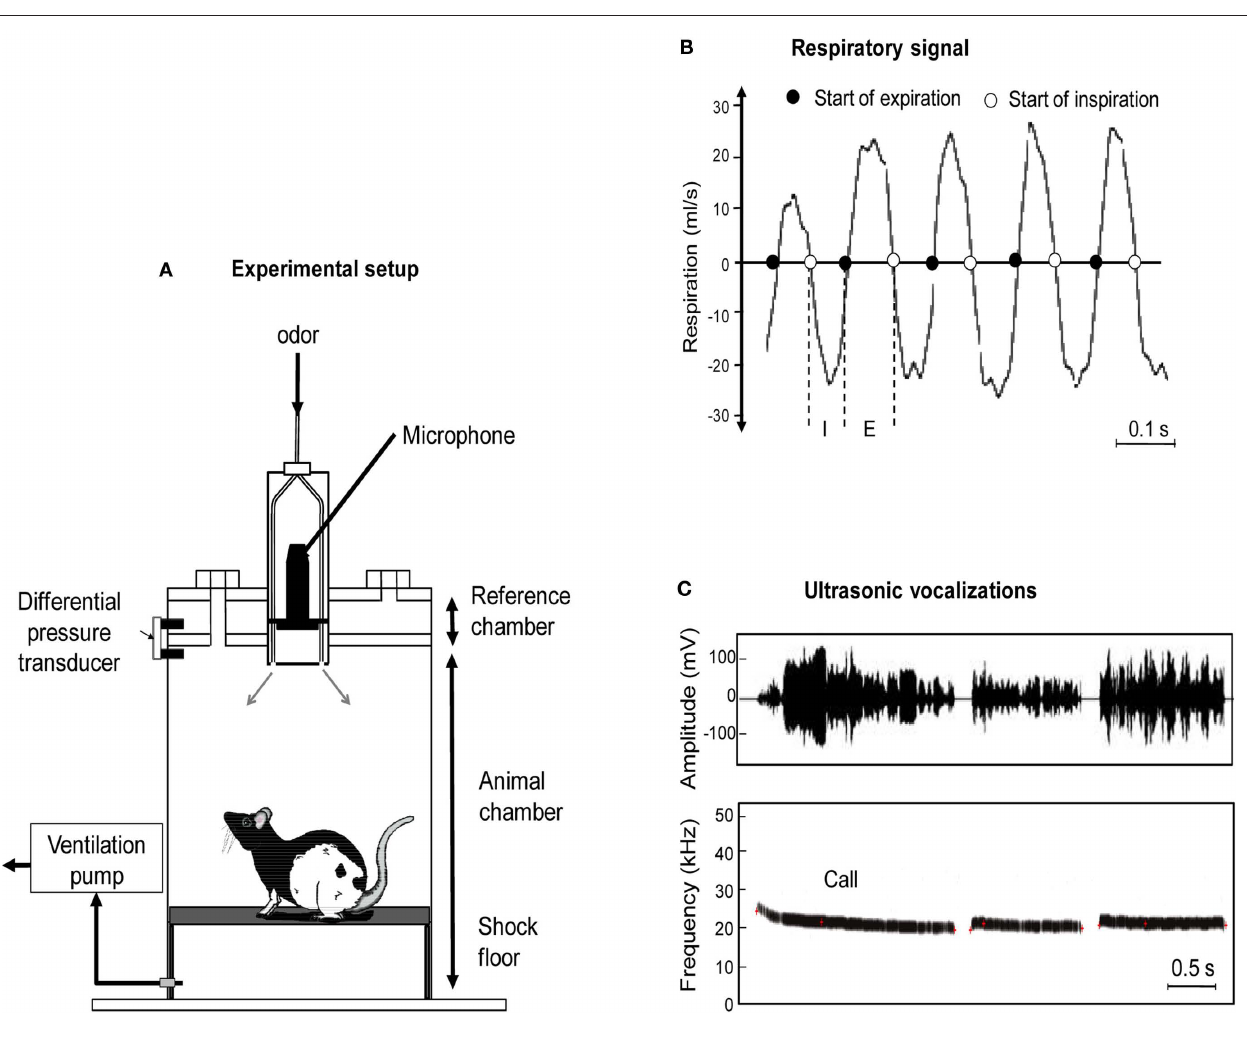
pump. An ultrasound microphone was inserted in the tower to monitor ultrasonic vocalizations (USV) emitted by the rats. The floor of the animal chamber has been equipped with a shock-floor allowing delivering scrambled foot-shock. (B) Individual example of raw respiratory signal. I, inspiration phase; E, expiration phase. (C) Individual example of ultrasonic vocalizations. Upper part : waveform of three successive USV. Lower part : corresponding